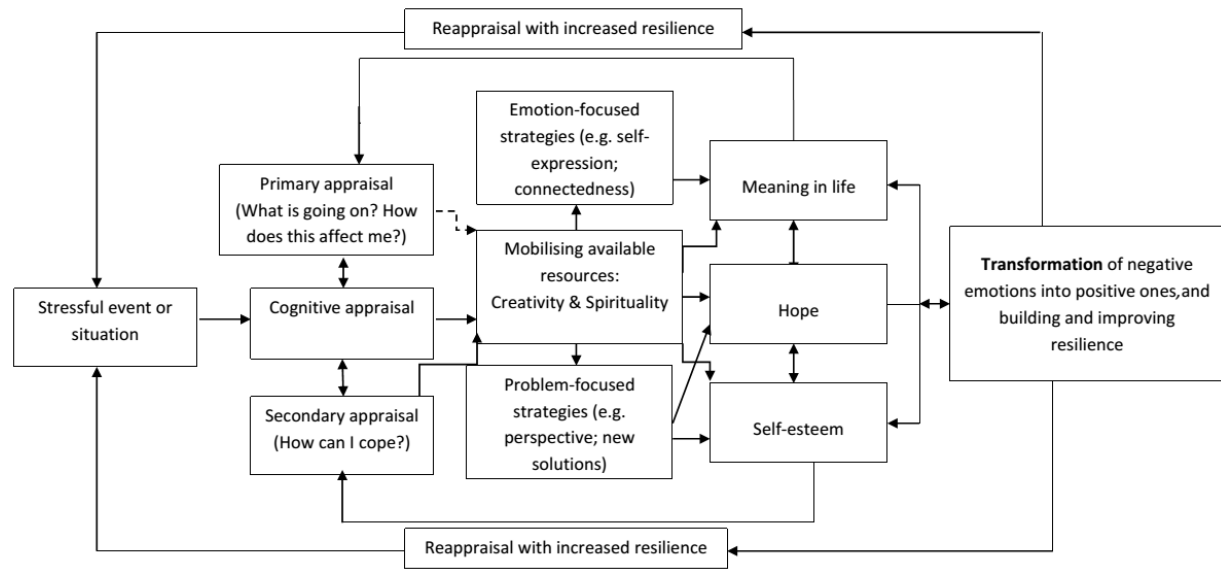
Figure 1. The revised transformative coping model (“TCM-R”; see [6] for the original